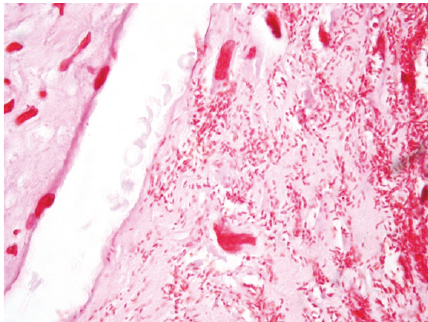
Figure 1: Gram-negative bacilli within chorionic villi (Gram stain, 1000x oil